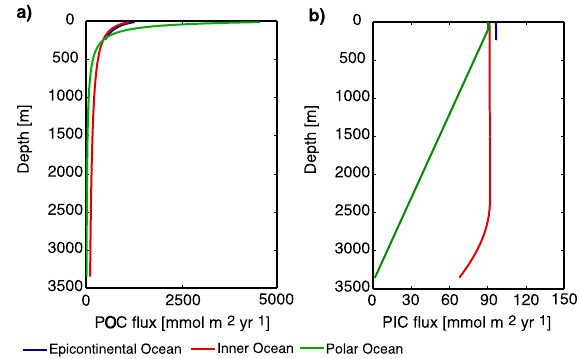
Figure 4: Simulated steady state depth profile of a) POC flux b) PIC export fluxes in the global Fig. 4. Simulated steady state depth profile of (a) POC flux (b) PIC export fluxes in the global ocean.